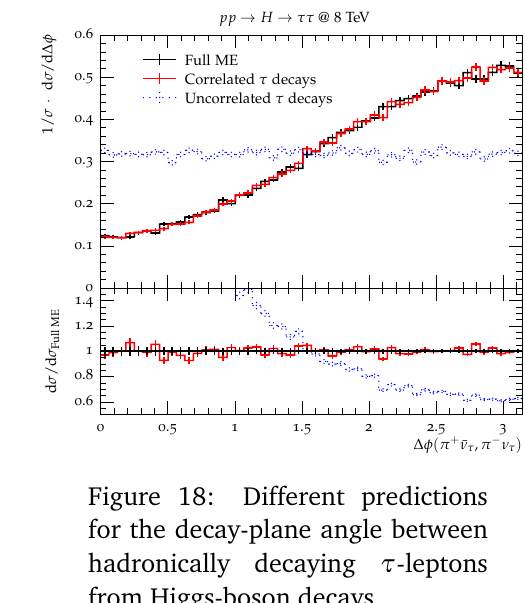
Figure 17: Results for semilep- tonic B 0 decays based on differ- ent form-factor models in compari- son to data from the B A B AR experi- ment [ 197 ] .